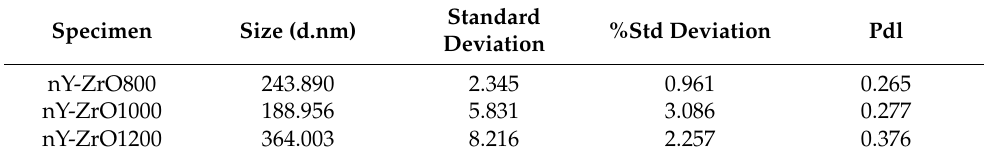
Table 3. Results from DLS analysis.